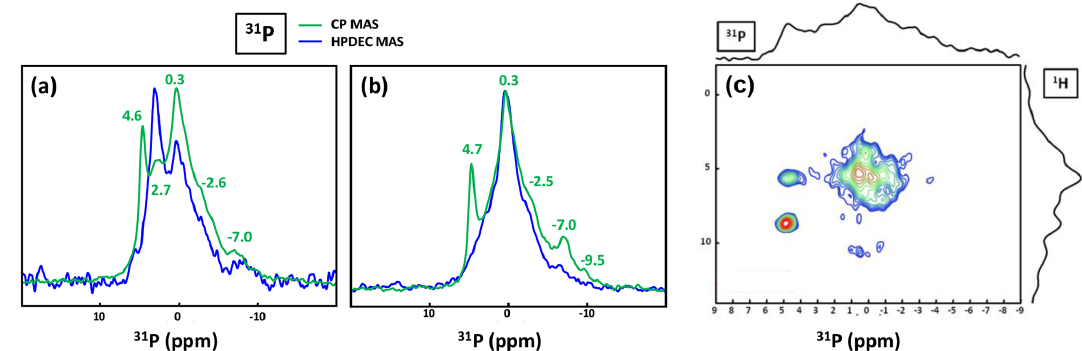
Figure 9. (a) 31 P MAS under high-power { 1 H } decoupling (in blue) and CP MAS (in green) under high-power { 1 H } decoupling NMR spectra of KS4. Some specific chemical shifts are highlighted. (b) 31 P MAS under high-power { 1 H } decoupling (in blue) and CP MAS (in green) NMR spectra of KS5 (representative of an ensemble of five KSs). Some specific chemical shifts are highlighted. (c) 1 H − 31 P HETCOR CP MAS NMR spectrum of KS4 (temperature control at − 20 ◦ C). All spectra shown here were recorded at 16.4T.